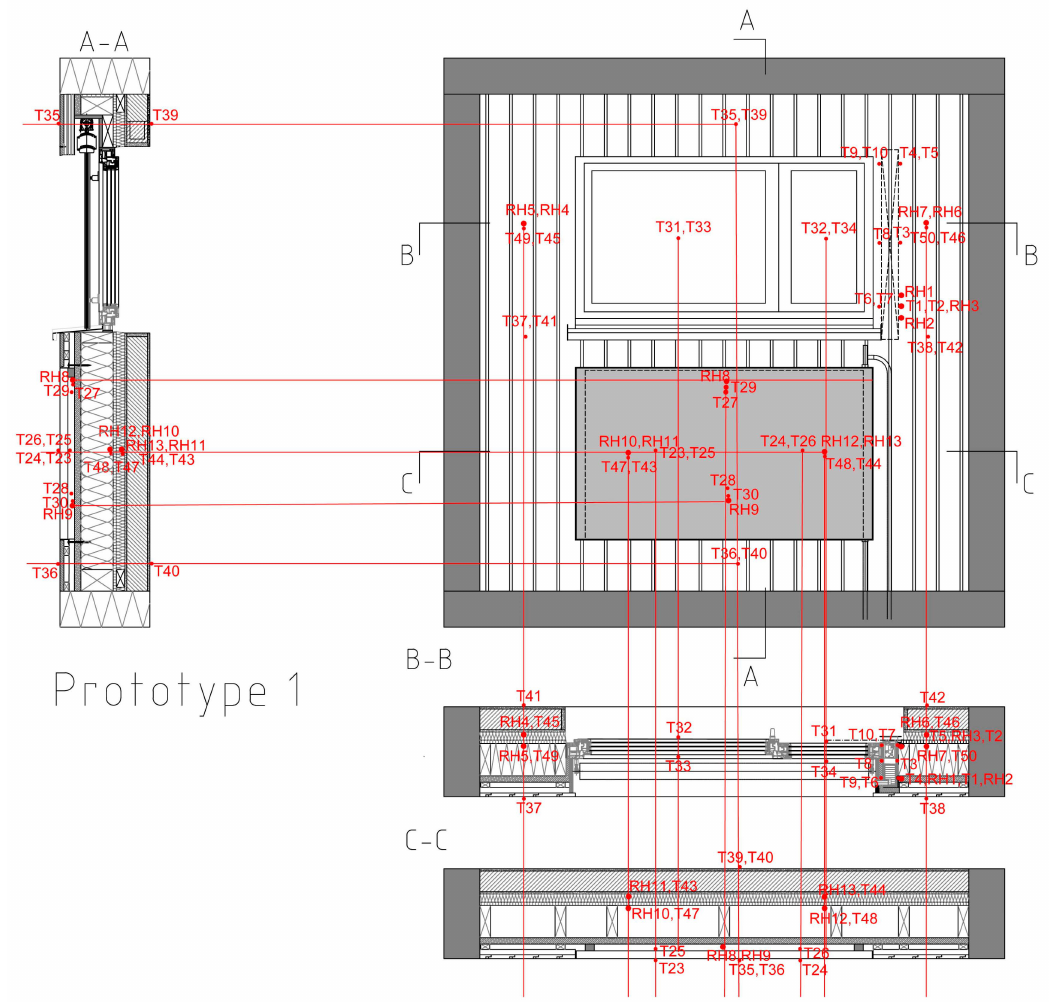
Figure 3. Position of the sensors during the test in the hot box facilities (design by EURAC and M. Calzolari). Temperature accuracy of sensors is high considering the sensor uncertainty ( ± 0.5 °C) and the thermal chamber uncertainty for temperature uniformity ( ± 1 was obtained, so it can be concluded that sensors measurement is correct considering